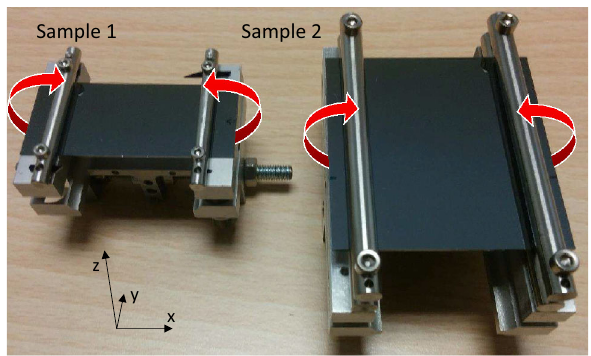
Fig. 2 Picture of the samples. The red arrows represent the imposed primary curvature